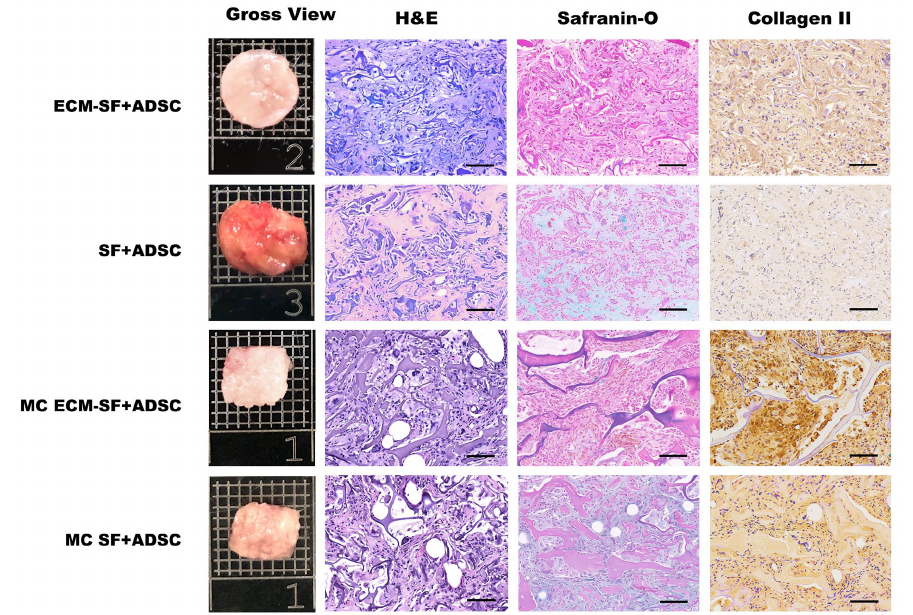
Figure 6. Gross view and histological examinations of the regenerated cartilage in nude mice for 12 weeks. Bar = 20 µm.